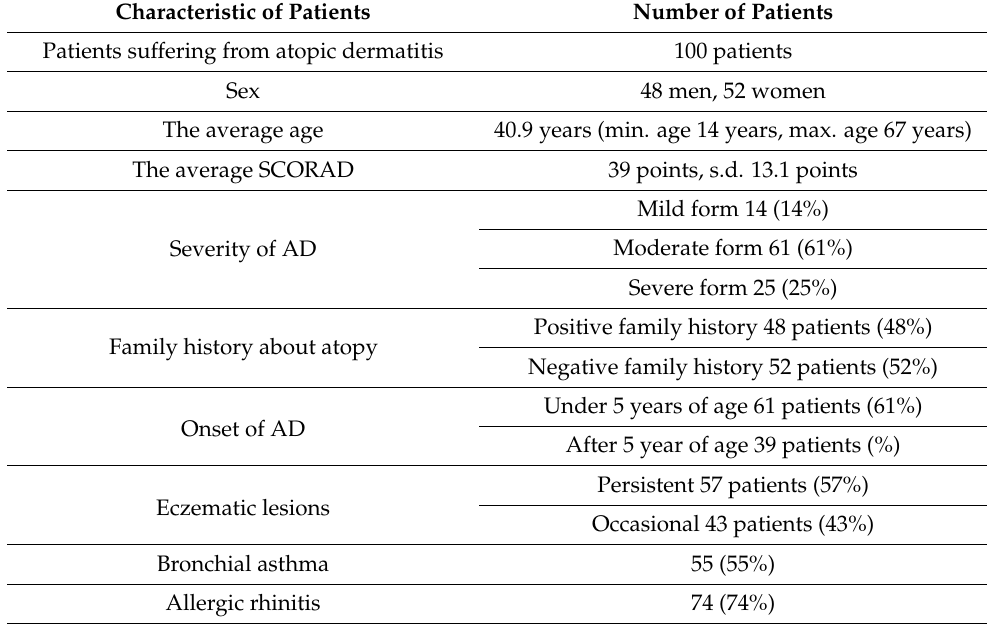
Table 1. The characteristic of patients.